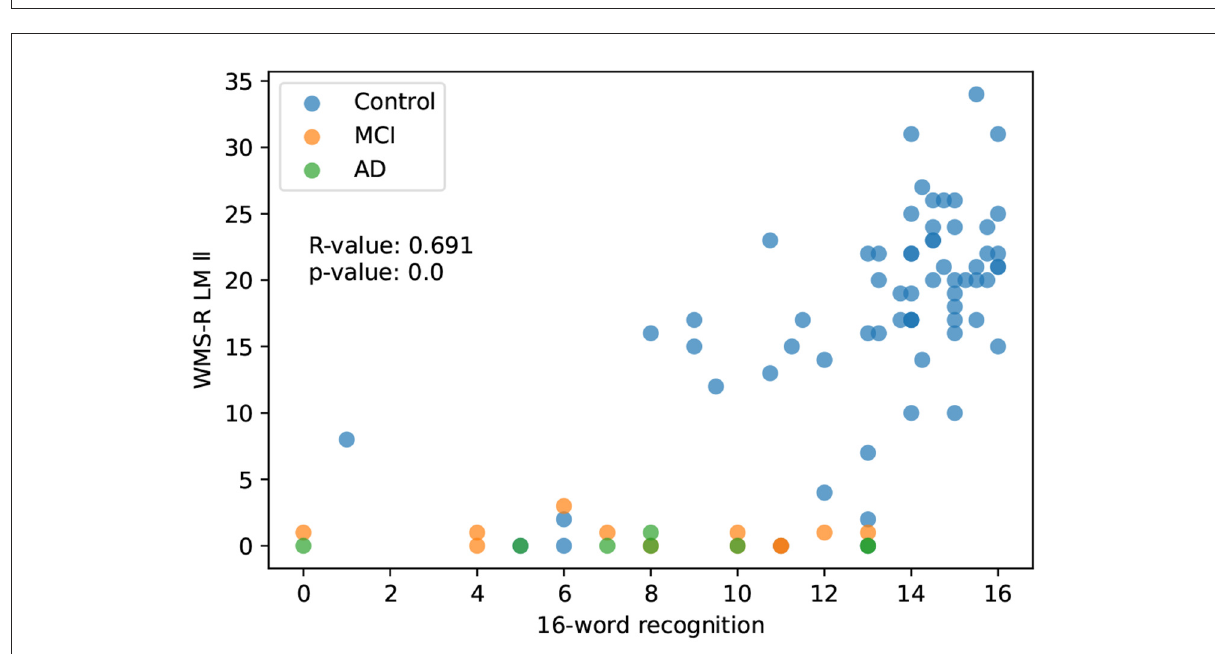
FIGURE4 The correlation between 16-word recognition and WMS-R delayed recall score.